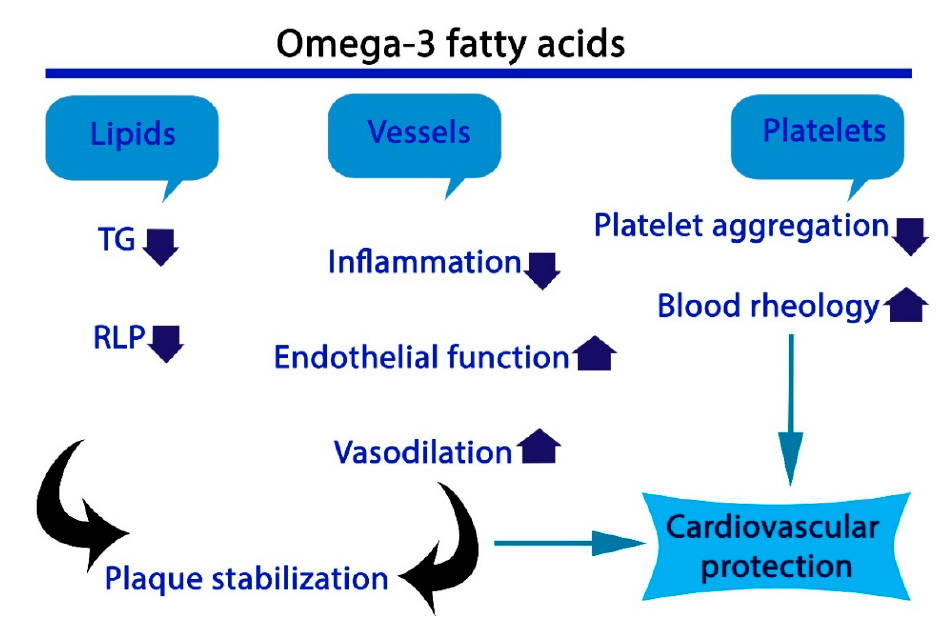
Figure 2. Role of omega-3 fatty acids in cardioprotection. (TG (triglycerides), RLP (Rmnant lipopro-